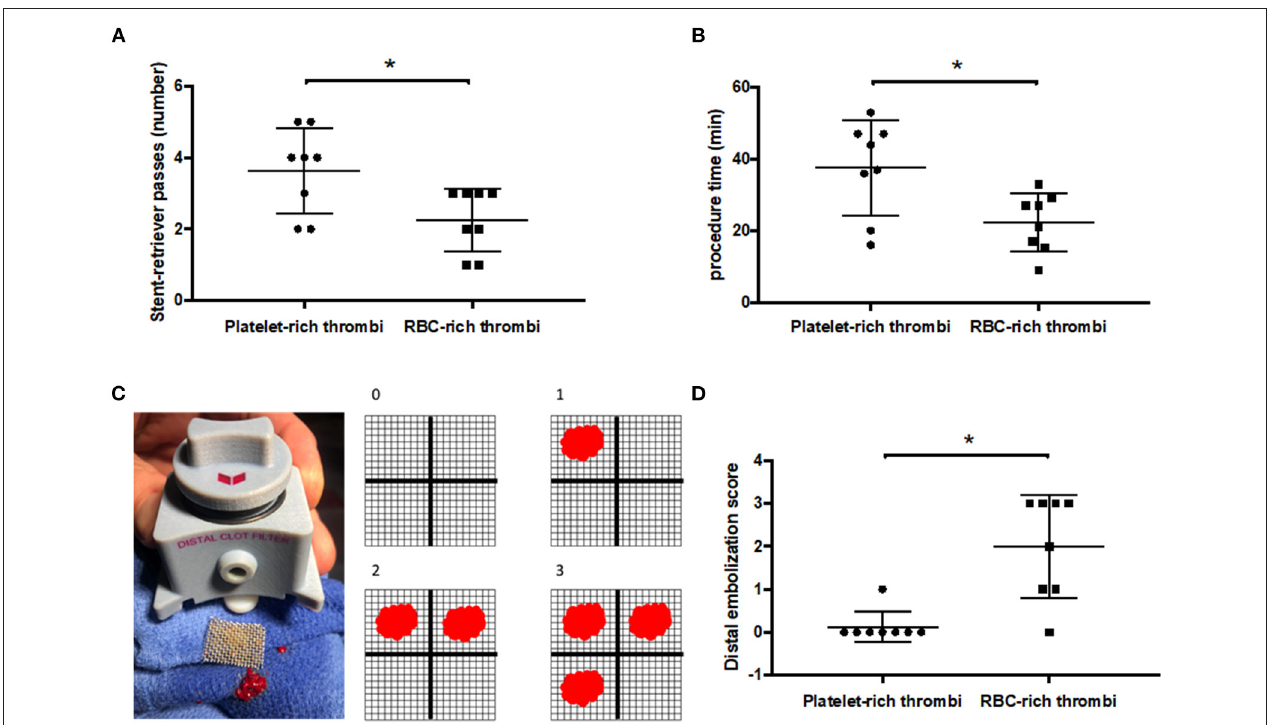
FIGURE 2 | Platelet-rich thrombi require more stent-retriever passes to achieve complete recanalization but release less distal emboli compared to RBC-rich thrombi. (A) Number of stent-retriever passes to achieve complete recanalization according to the thrombus composition (platelet and red blood cell (RBC)-rich thrombi). (B) Duration of the procedure to achieve complete recanalization. (C) Illustration of the distal thrombus filter with its removable mesh of 0.7mm struts (left panel) and the illustration of the distal embolization score (right panel). (D) Distal embolization score according to the thrombus composition (a higher score indicating more distal emboli). * p <